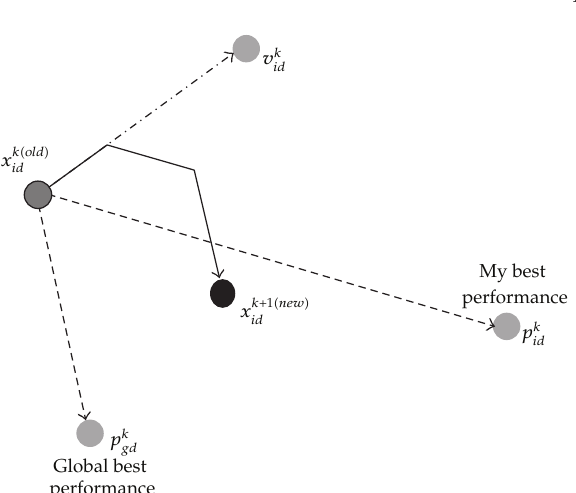
Figure 2: Position update of